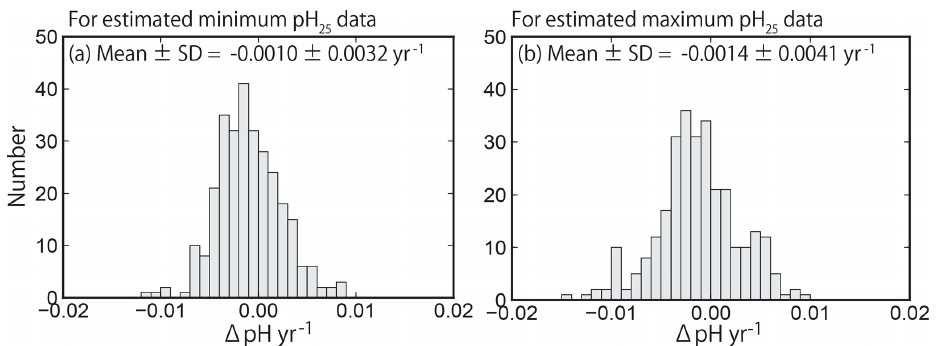
Figure 10. Same as Fig. 7 but showing the pH 25 trends at 289 sites (selected by quality control step 3). The value of pH 25 was estimated using the method of Lui and Chen